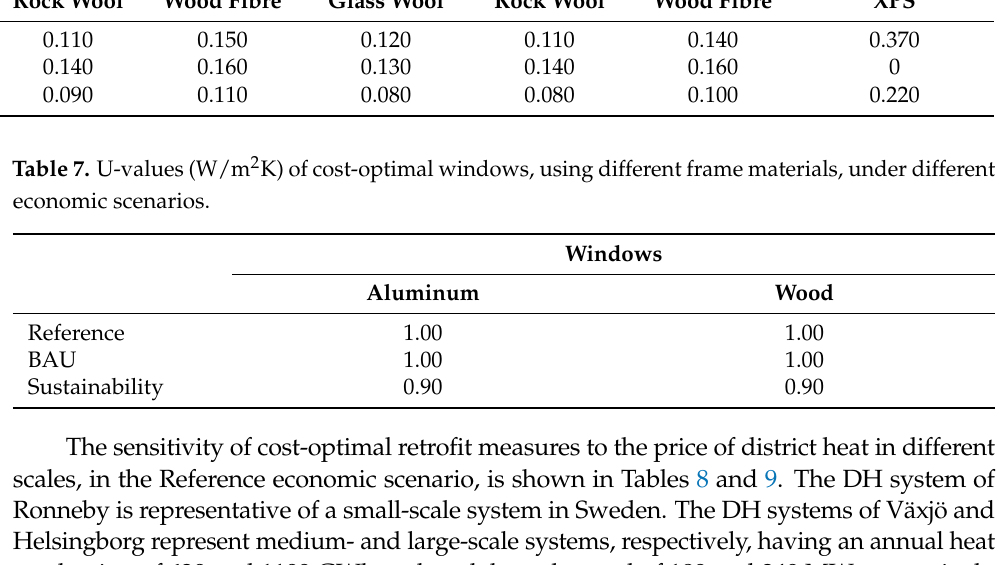
Table 6. U-values (W/m 2 K) of cost-optimal extra insulation, using different materials, under different economic scenarios.